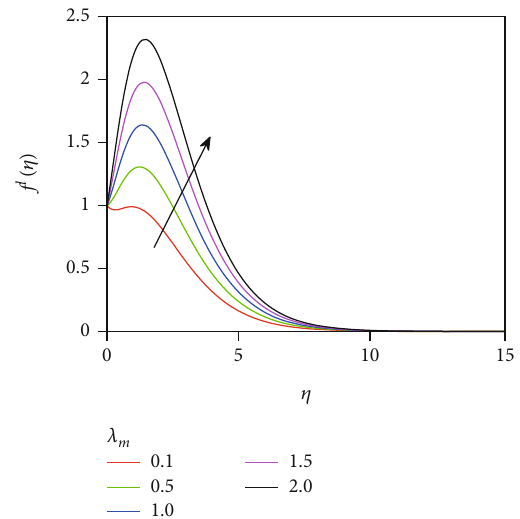
Figure 13: Signi fi cance of the nonlinear convective concentration parameter on velocity